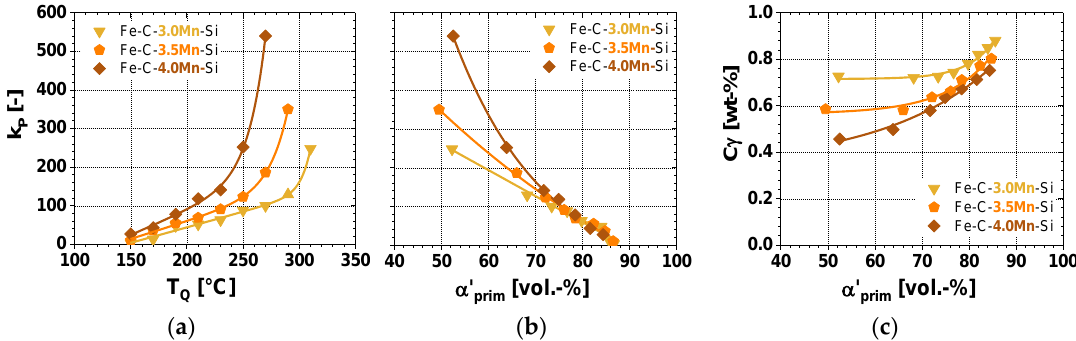
Figure 11. k P -values indicating the RA-stability as a function of ( a ) T Q and ( b ) α’ prim . ( c ) C-content in RA as a function of α’ prim for the investigated steels.